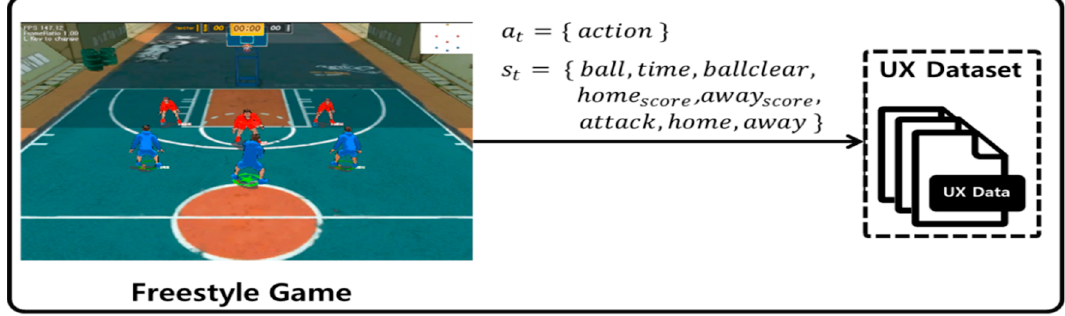
Figure 6. UX dataset of Freestyle game.